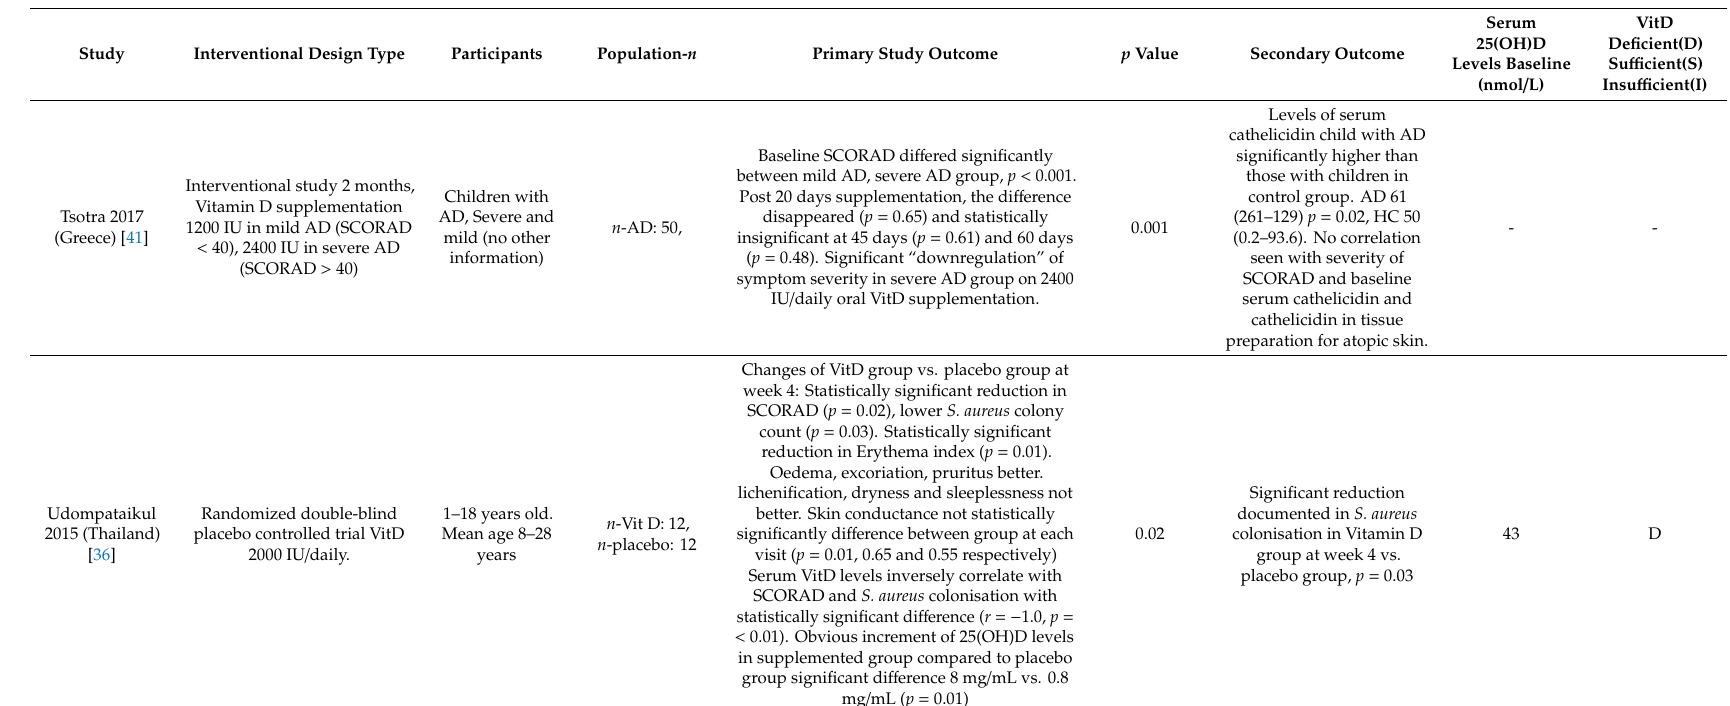
Changes of VitD group vs. placebo group at week 4: Statistically significant reduction in SCORAD ( p = 0.02), lower S. aureus colony count ( p = 0.03). Statistically significant reduction in Erythema index ( p = 0.01). Oedema, excoriation, pruritus better. lichenification, dryness and sleeplessness not better. Skin conductance not statistically significantly di ff erence between group at each visit ( p = 0.01, 0.65 and 0.55 respectively) Serum VitD levels inversely correlate with SCORAD and S. aureus colonisation with statistically significant di ff erence ( r = − 1.0, p = < 0.01). Obvious increment of 25(OH)D levels in supplemented group compared to placebo group significant di ff erence 8 mg / mL vs.